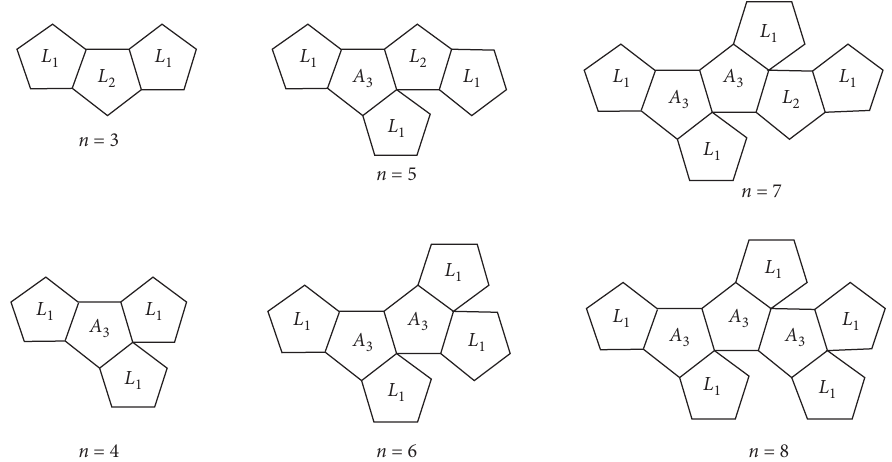
Figure 7: Catacondensed pentagonal system F Table 1: Values of Θ